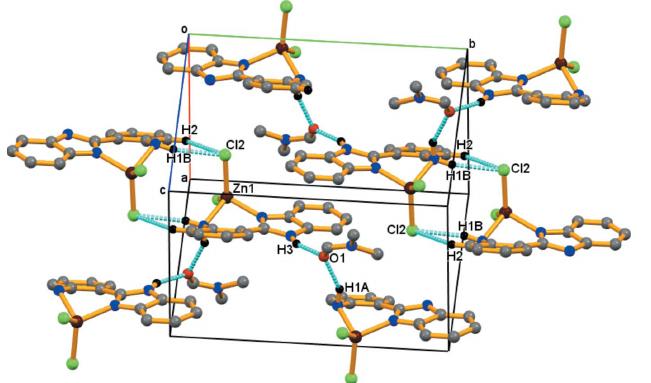
Figure 4 The Hirshfeld surface of the title complex mapped over ( a ) d norm , ( b ) d e , ( c ) shape-index, and ( d ) curvedness. Red spots 1,2, and 3 in ( a ) and ( b ) correspond to N—H (cid:2)(cid:2)(cid:2) O, N—H (cid:2)(cid:2)(cid:2) Cl, and C—H (cid:2)(cid:2)(cid:2) Cl hydrogen